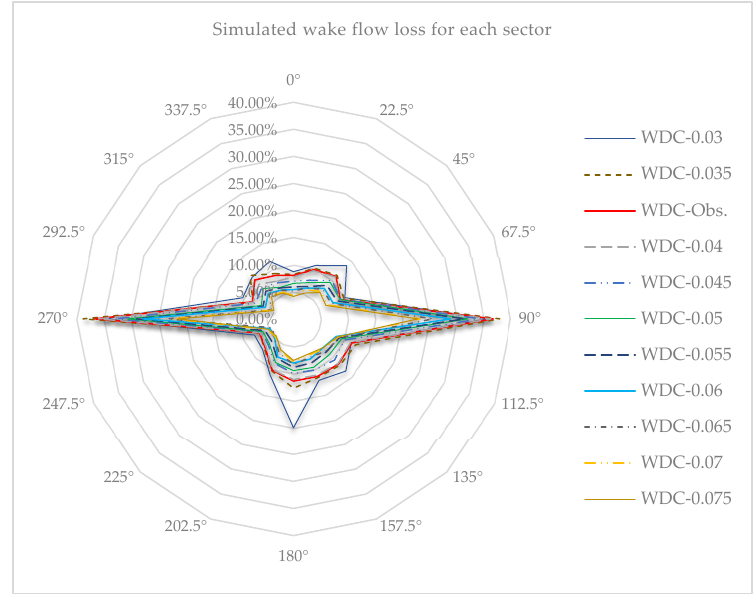
Figure 4. Simulated wake loss for each sector.